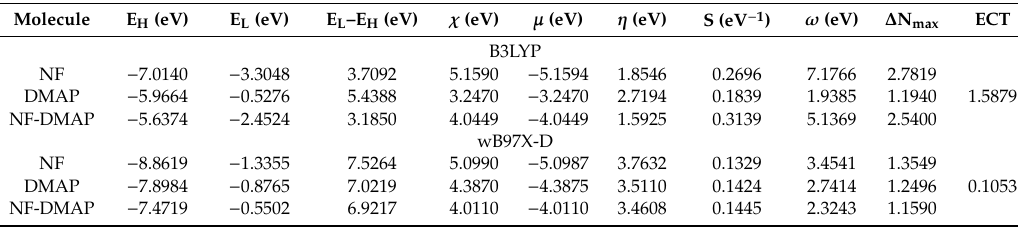
Table 2. Calculated E HOMO , E LUMO , energy gap (E L –E H ), chemical potential ( µ ), electronegativity ( χ ), global hardness ( η ), global softness (S) and global electrophilicity index ( ω ) at 298.15 K for NF, DMAP and NF-DMAP using wB97X-D and B3LYP level of